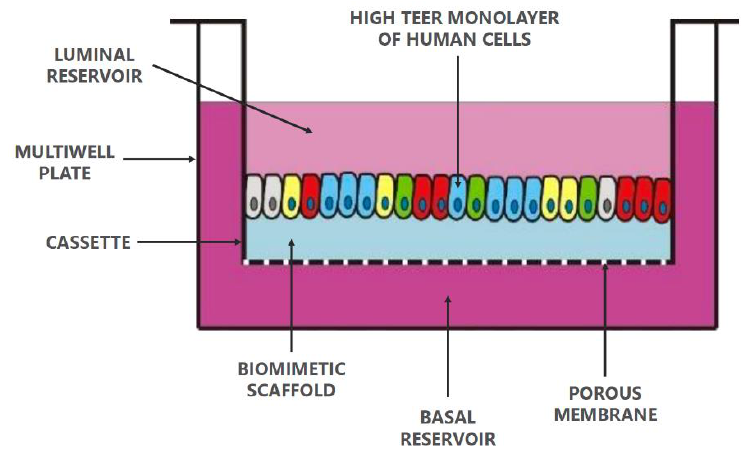
Figure 6. RepliGut ® planar growing primary epithelial cells on a biomimetic scaffold. Adopted with permission from [210], Altis Biosystems.